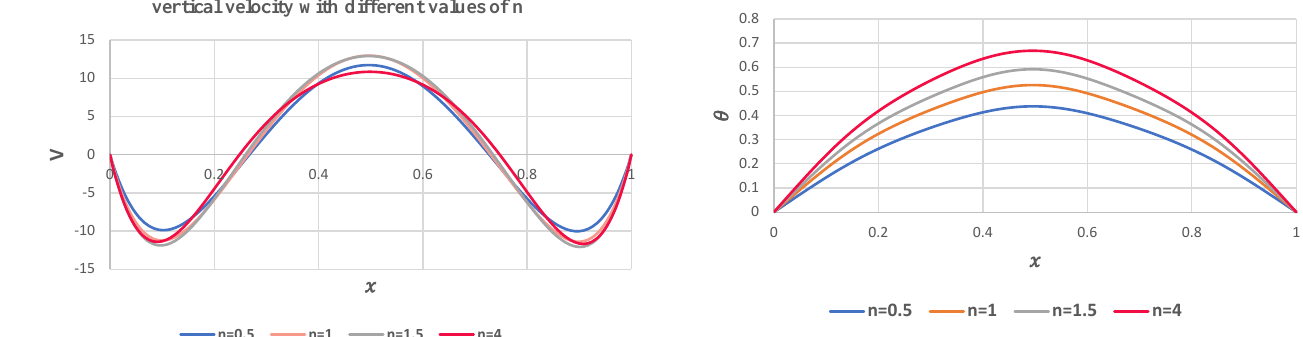
Figure 8. The influence of an inner superellipse shape enclosures on the vertical velocities and temperature profiles.